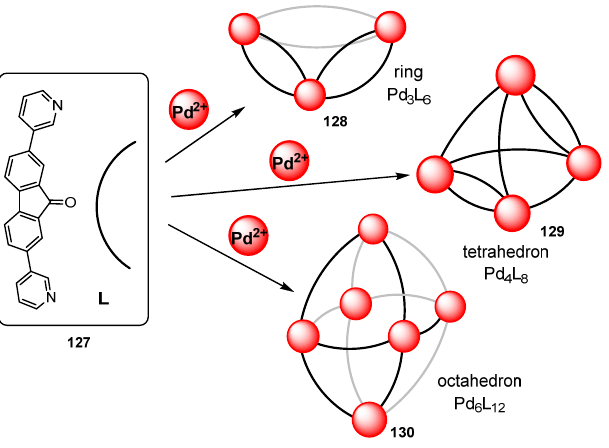
Figure 36. Schematic representation of the synthesis and structure of ring cages Pd 3 L 6 128 , Pd 4 L 8 129 and Pd 6 L 12 130 containing bridging fluorenone derivatives 127 . Adapted from [114].